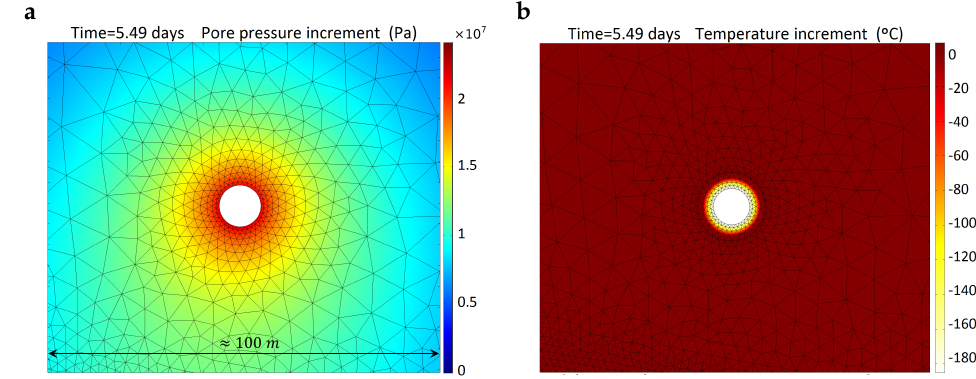
Figure 3. Results of the pore pressure increase ( a ) and the temperature increase ( b ) around the injection well at the moment of fault reactivation in the model. We show how the cooling caused by the injection has hardly spread around the well, contrary to what happens with the pressure, which spreads to areas further away from the